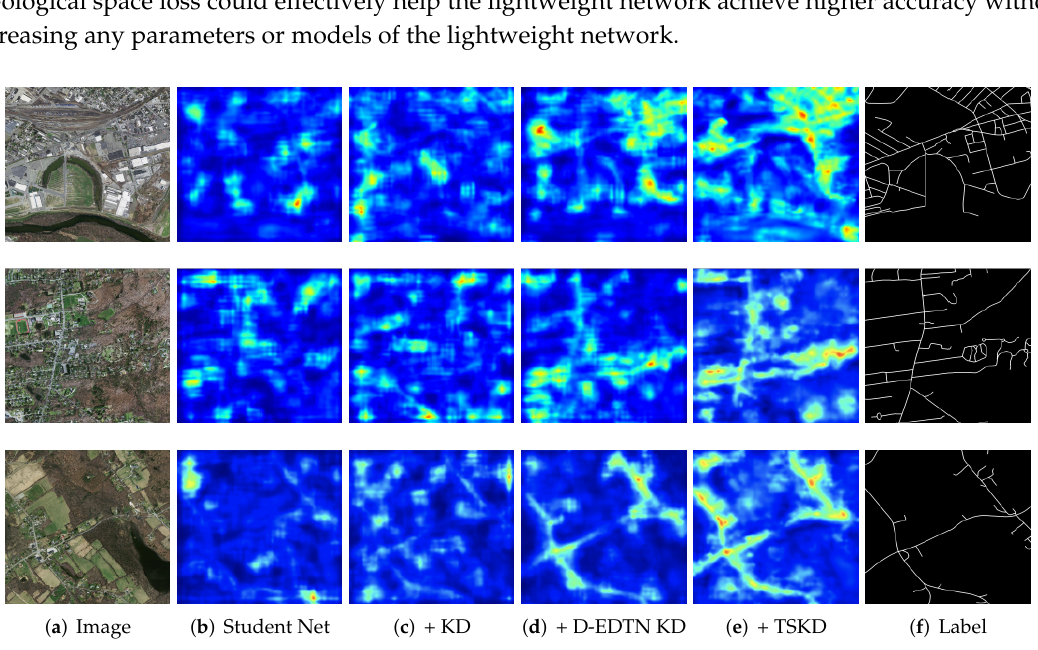
Figure 9. Middle-layer feature comparison of the student networks based on different kinds of knowledge distillation with the Massachusetts Dataset. ( a ) Image; ( b ) results of the student net; ( c ) results of student net with knowledge distillation (KD); ( d ) results of the student net with D-EDTN KD; ( e ) results of the student net with TSKD; ( f )